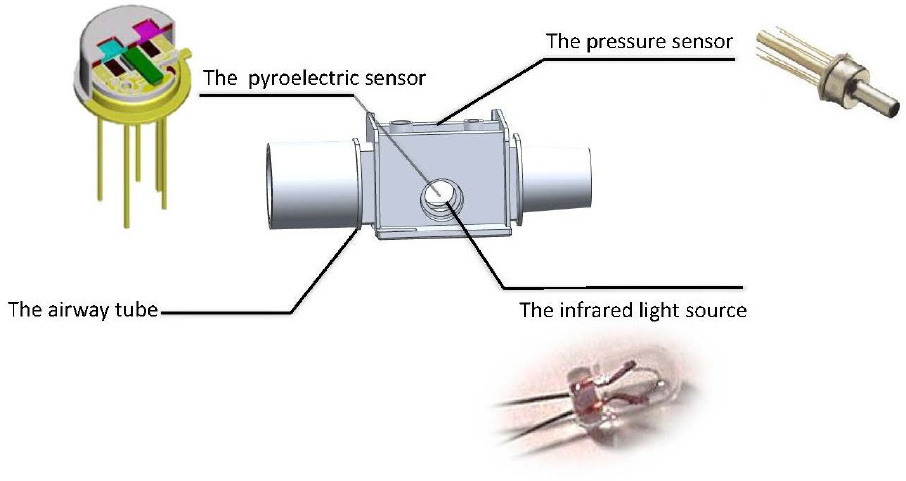
Figure 2. Biomedical module.